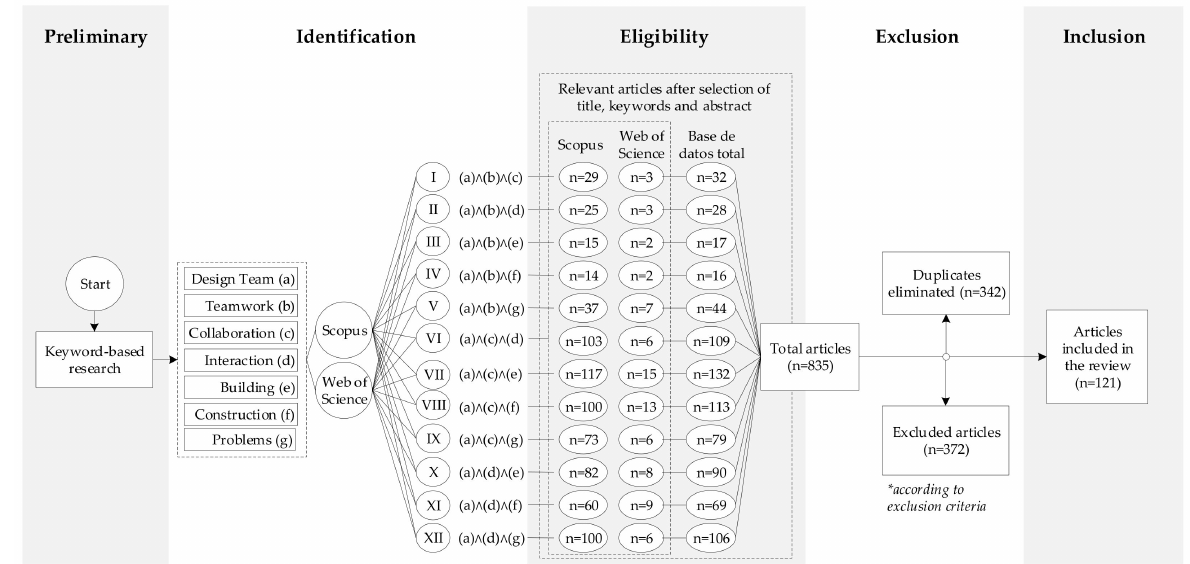
Figure 2. Outline of the literature collection and selection